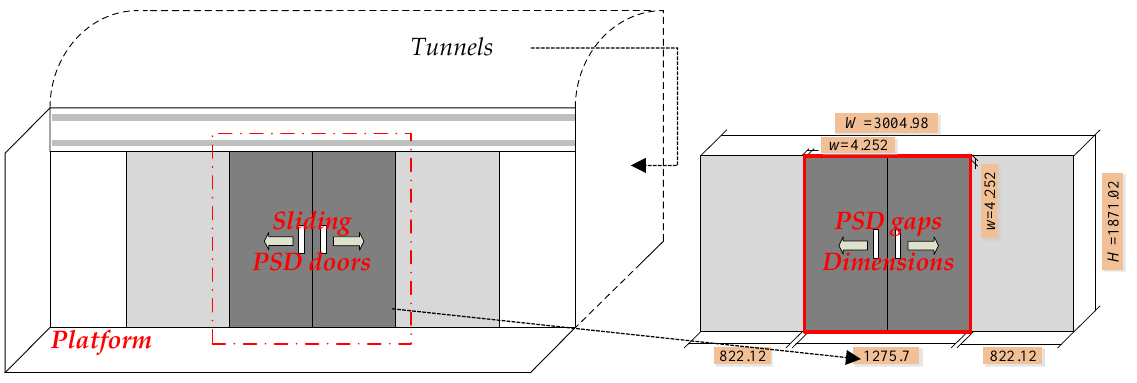
Figure 2. Geometry model and dimensions of PSD